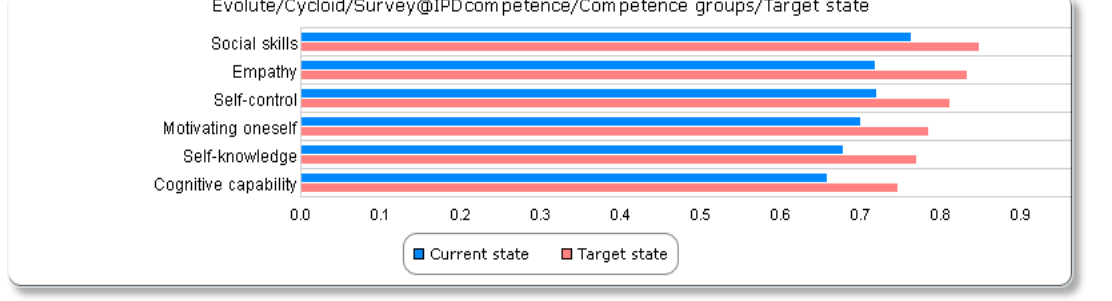
Figure 3. Project managers’ subgroup competencies sorted according to their significance (target state).